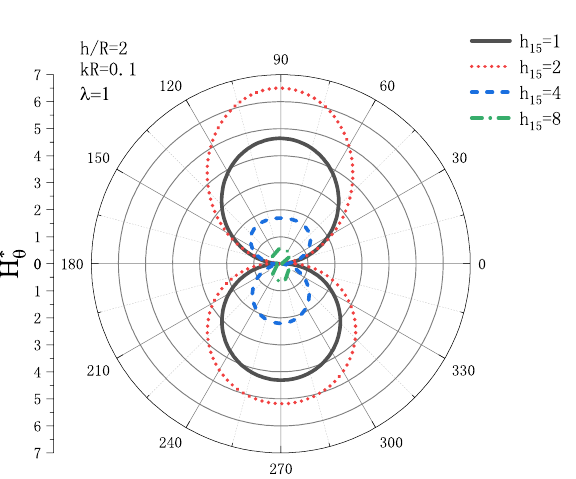
* h 15 when incident frequency kR = 0.1 θ vs. the ratio of